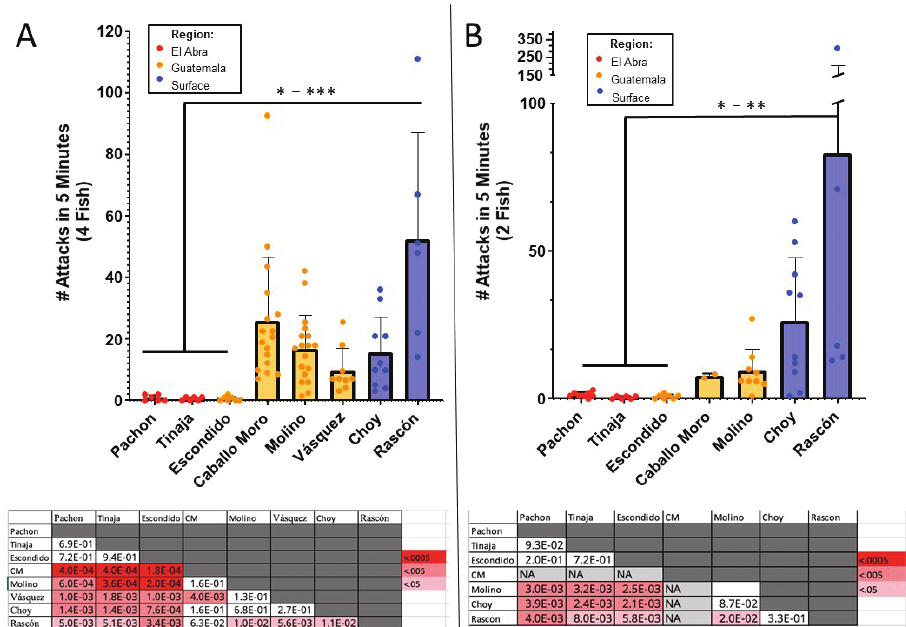
Figure 3. Number (with SD) of ramming and biting attempts in the four fish A and two fish B assays, for Sierra de El Abra (Pachón and Tinaja), Sierra de Guatemala (Escondido, Caballo Moro, Molino, and Vásquez) cave fish and surface fish (Choy and Rascón). With the exception of Escondido cave, Sierra de Guatemala cave fish were significantly more aggressive than Sierra de El Abra cave fish. In several compari- son, Sierra de Guatemala cave populations were as aggressive and not significantly different than some of the surface fish. Tables below graphs show significance levels. Notice that Pachón, Tinaja and Escondido are significantly less aggressive than all of the